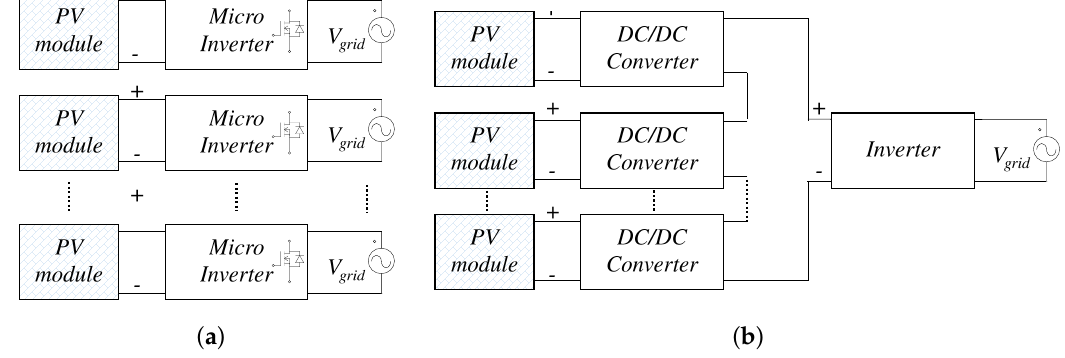
Figure 11. Distributed MPPT architectures: ( a ) micro-inverters and ( b ) front-end DC optimizers.